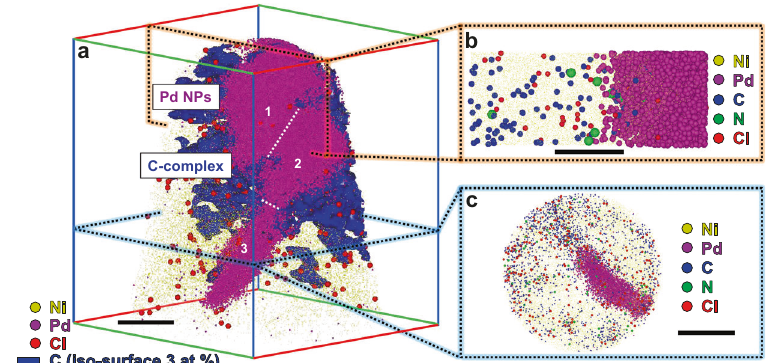
Fig. 3 Atom probe tomography (APT) reconstruction of Pd NPs, synthesized by adding Cl anions, embedded in Ni. a Three-dimensional atom map of Pd atoms and iso-concentration (3 at.%) surfaces of C; the white dotted lines indicate the boundaries of each NP. b, c Slices viewed along with the Pd NPs. (Scale bars: 10 nm in a , 5 nm in b , 20 nm in